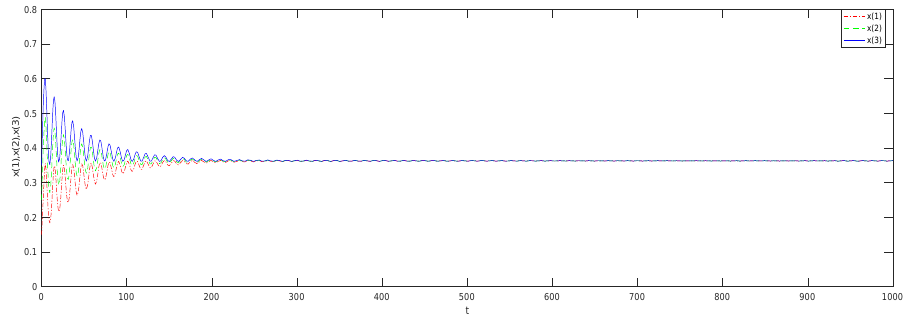
Figure 1: Equilibrium point (0.362, 0.362, 0.362) is asymptotic stability with b = 0.8795, τ = 3.59.